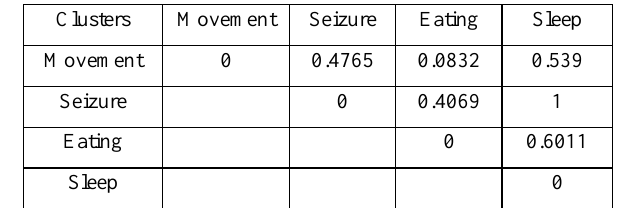
Figure 2 . Graphs of PSD levels of events obtained at different frequencies The relative distances between the centers of the obtained clusters are given in Table 1, and the values of the standard J from the deviations of the feature descriptions of events G p centers of the clusters are given in Table 2.